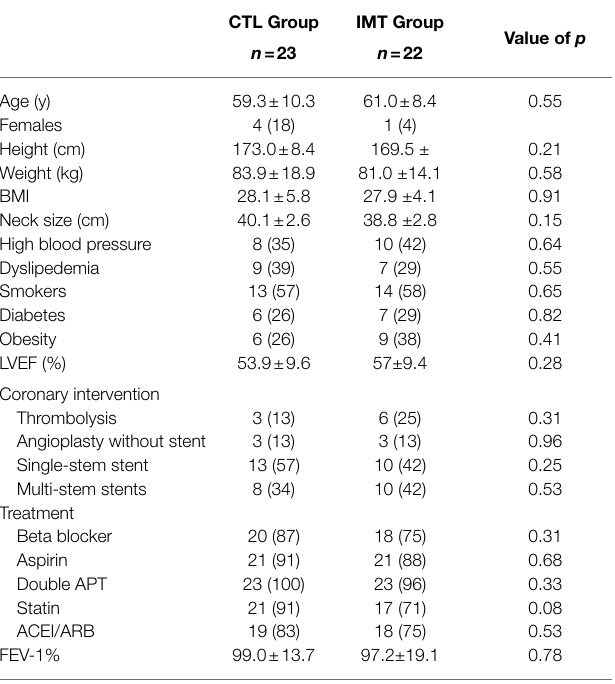
TABLE 1 | Baseline